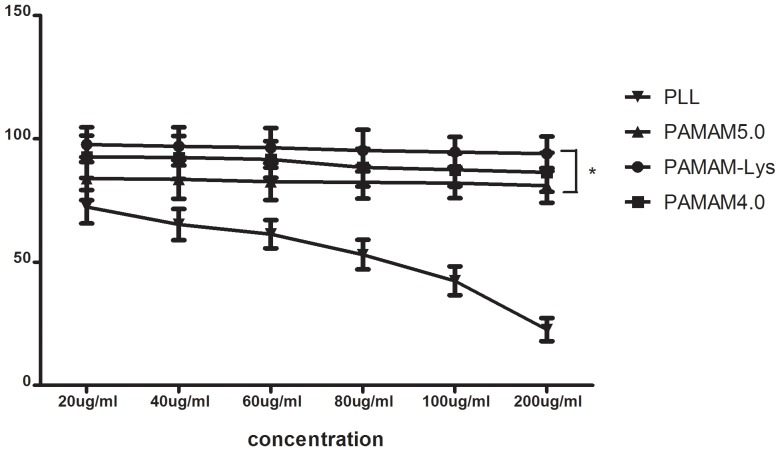
Cytotoxicity assay in 293T cells PLL (▪), PAMAM5.0G (•), PAMAM-Lys (▾), PAMAM4.0 (▴).Each DNA complex was incubated with the cells for 24± standard deviation of the number of live cell every 100 cells. *p<0.05.